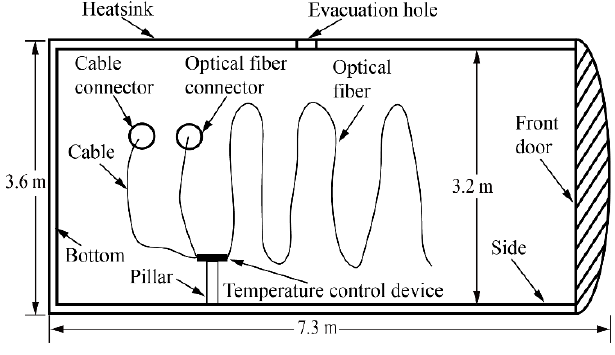
Figure 1. The heatsink.